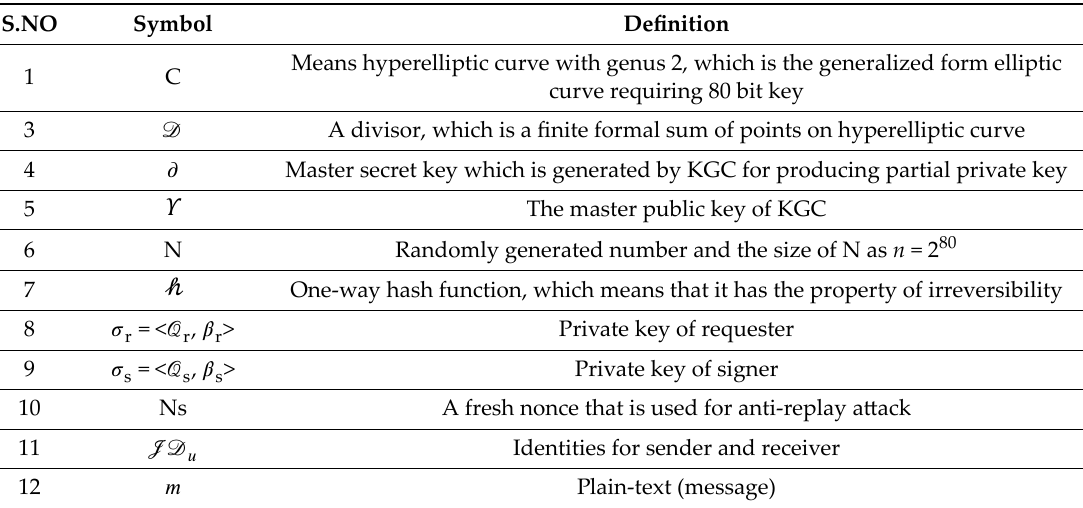
Table 1. Notations used in proposed algorithm.